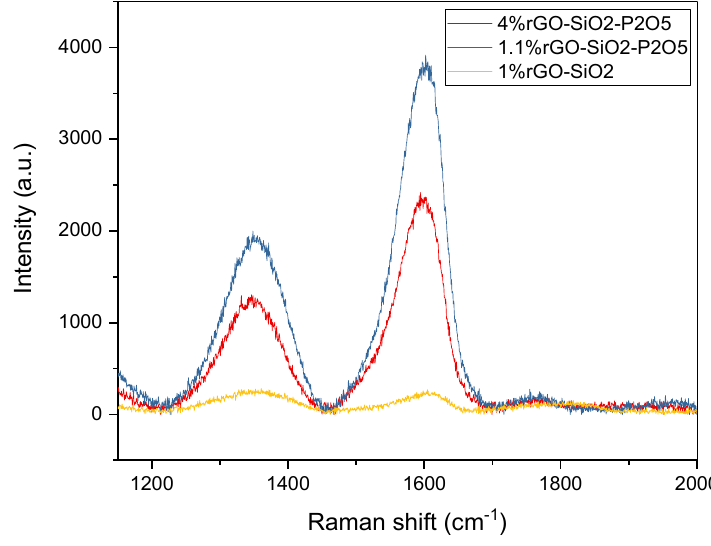
Figure 16. Raman spectra of a selection of the sol-gel films deposited on ITO-coated glass substrate. Higher D bands were observed in samples 4%rGO-SiO 2 -P 2 O 5 and 1.1%rGO-SiO 2 -P 2 O 5 as